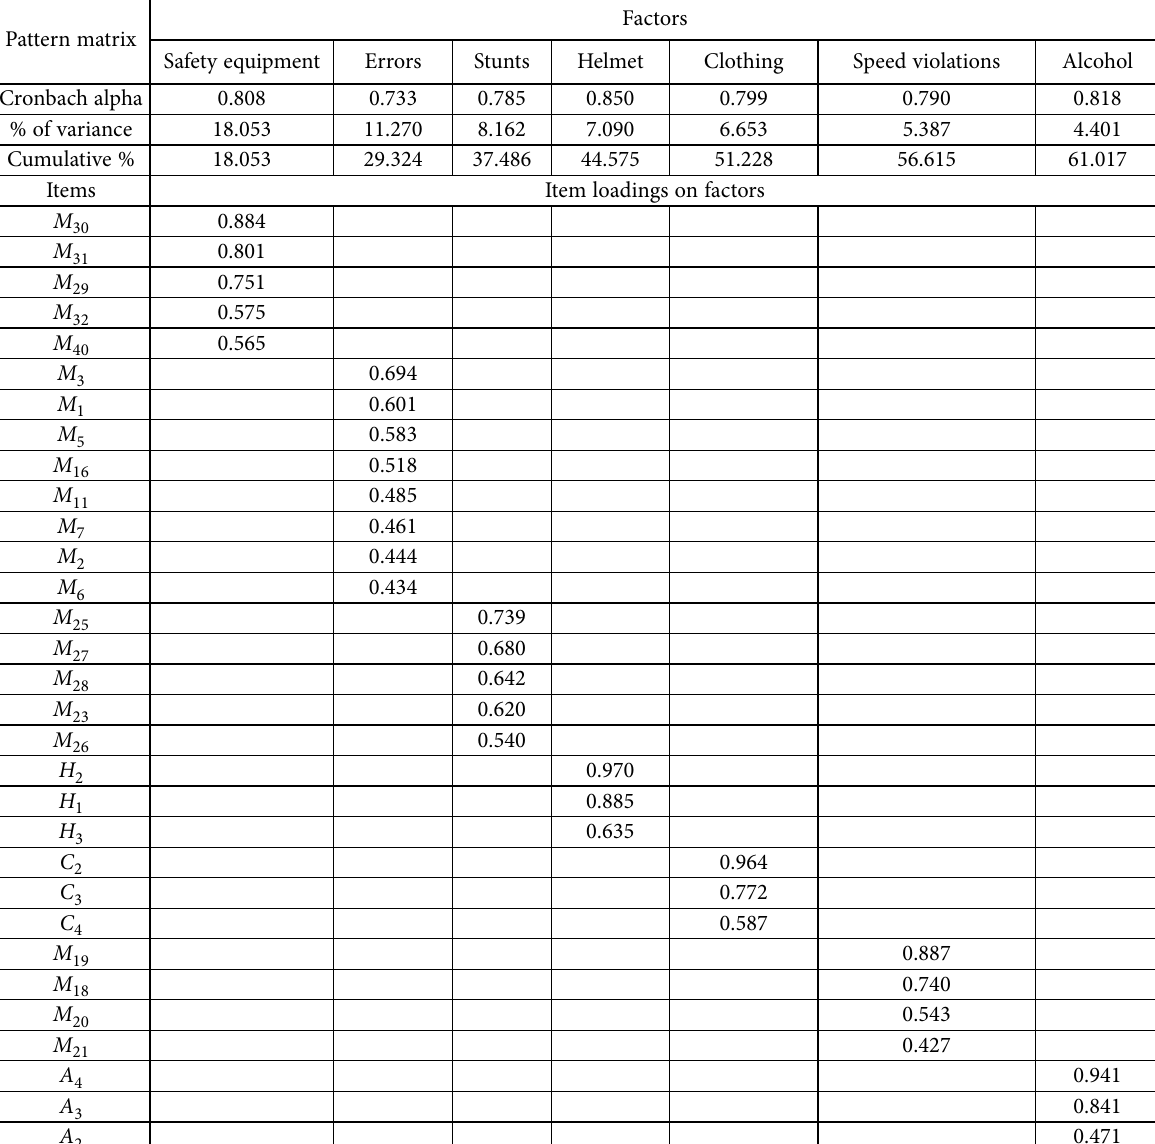
Table 4. Achieved results of the rotated factor pattern matrix (EFA – Exploratory Factor Analysis) Pattern matrix